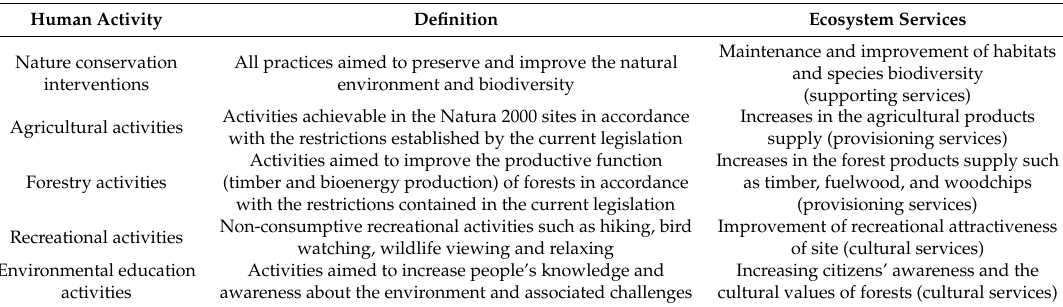
Table 1. Human activities in the Natura 2000 sites and e ff ects on ecosystem services provision.